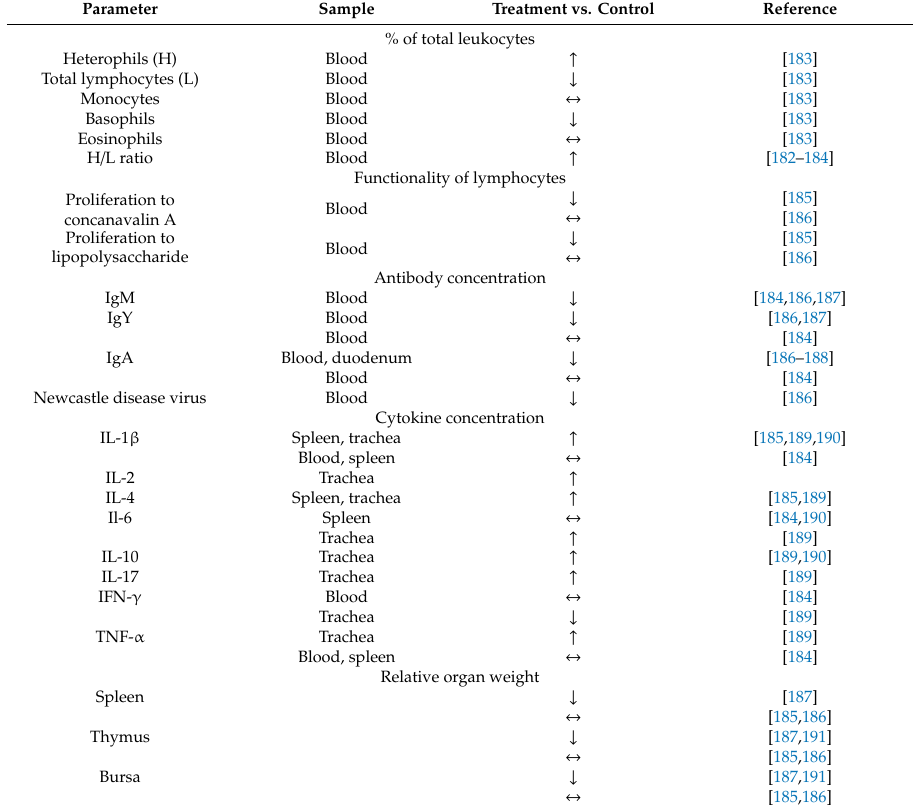
Table 4. Alterations of immune parameters of chickens exposed to ammonia (NH 3 ) (treatment) compared to control groups. Parameter Sample Treatment vs. Control